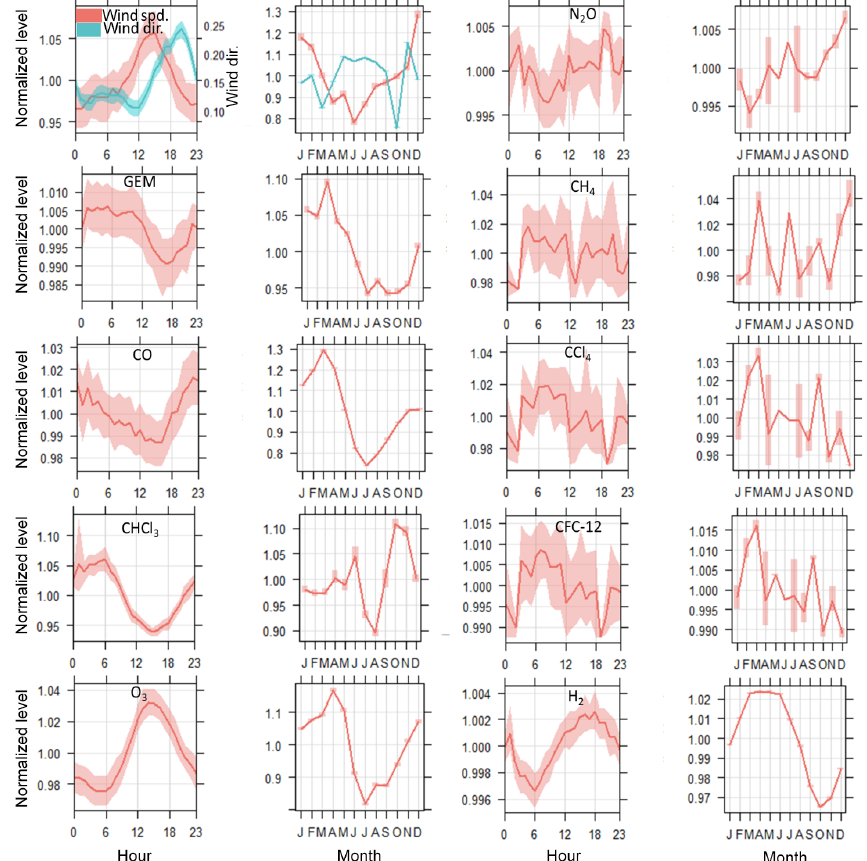
Figure 4. Diurnal cycle and seasonal cycle of mercury and species loaded in the PMF matrix. The shaded areas are the 95% confidence intervals in the mean. ∗ Wind direction is normalized with west 90 ◦ as − 1 and east (270 ◦ ) as